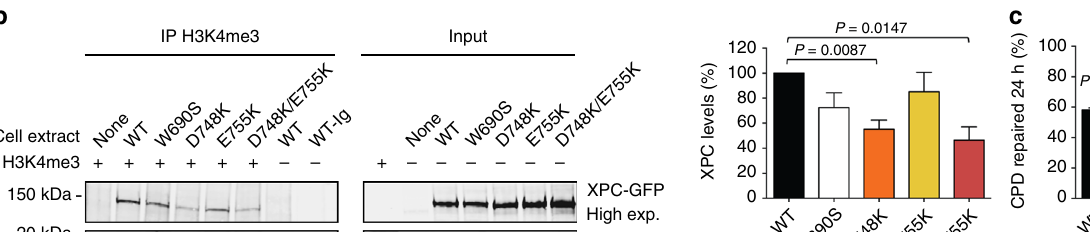
software. Cell numbers displaying the indicated spots were determined by counting all CPD-positive cells with the respective protein staining. The quanti fi ed protein levels at UV lesion sites were expressed as the ratio of fl uorescence intensity at the damage spot and the respective intensity in the remaining nuclear area after subtraction of the background intensity outside the nucleus.